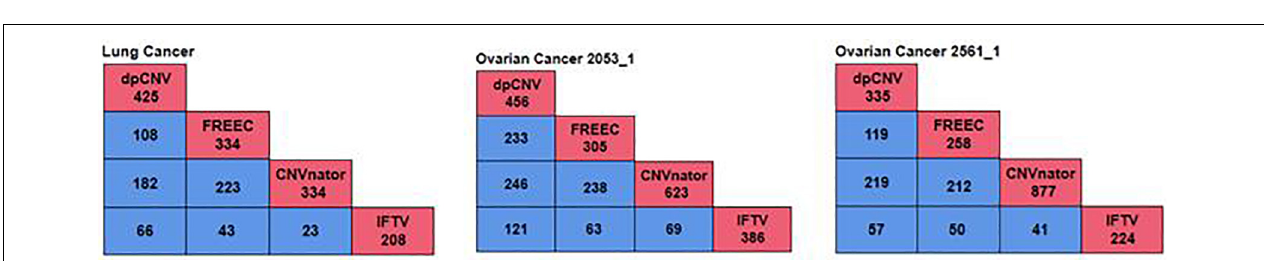
FIGURE 4 | Performance comparisons between our proposed method and the four peer methods in terms of sensitivity, precision, and F1-score (colored curves) on simulation data.